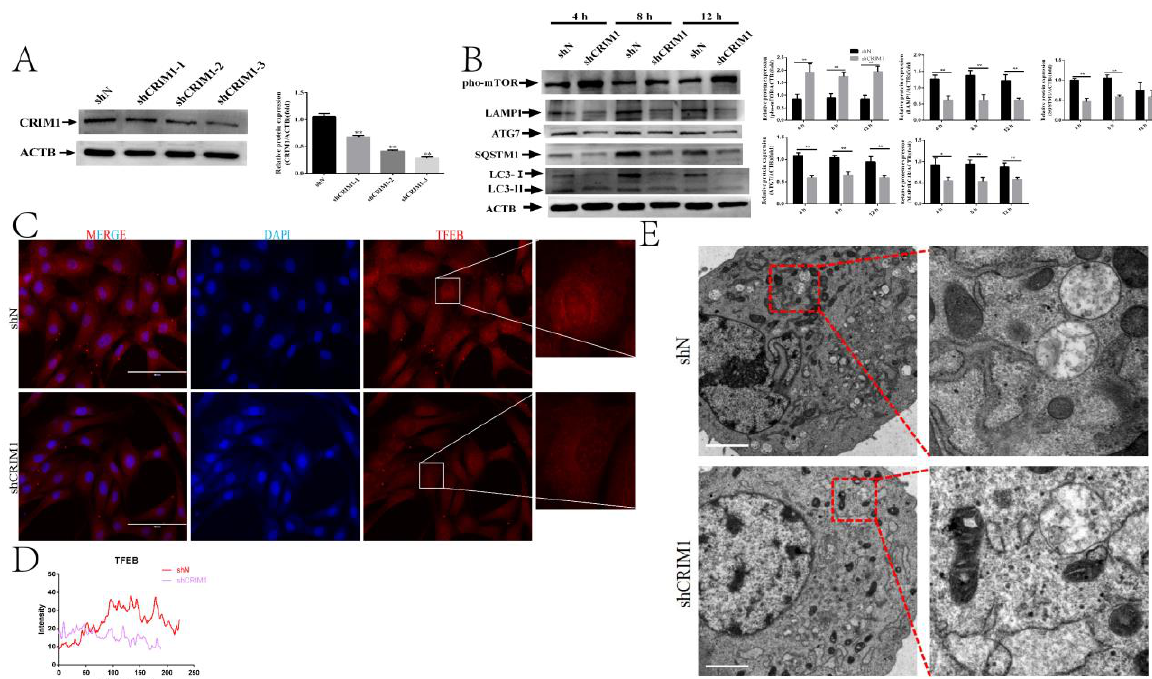
Figure 2. Knockdown of CRIM1-inhibited autophagy under P 4 , E 2 and IFN- τ treatment. ( A ) EECs were infected with a lentivirus specific for CRIM1 and a negative lentivirus (shN) for 48 h. Western blot analysis of CRIM1 levels in EECs. ( B ) After being treated with P 4 , E 2 and IFN- τ , total proteins from EECs were subjected to Western blotting. ( C , D ) Fluorescence microscopy images of TFEB expression in EECs and histograms of fluorescence intensity. Representative images of three independent experiments are shown. Scale bar = 100 µ m. ( E ) EECs were treated with P 4 , E 2 and IFN- τ for 12 h. The EECs were fixed and processed for TEM analysis. Scale bar = 2 µ m. The data are presented as the means ± SEM of three independent experiments. * Significant difference ( p < 0.05) compared with other groups; ** Significant difference ( p < 0.01) compared with other groups.